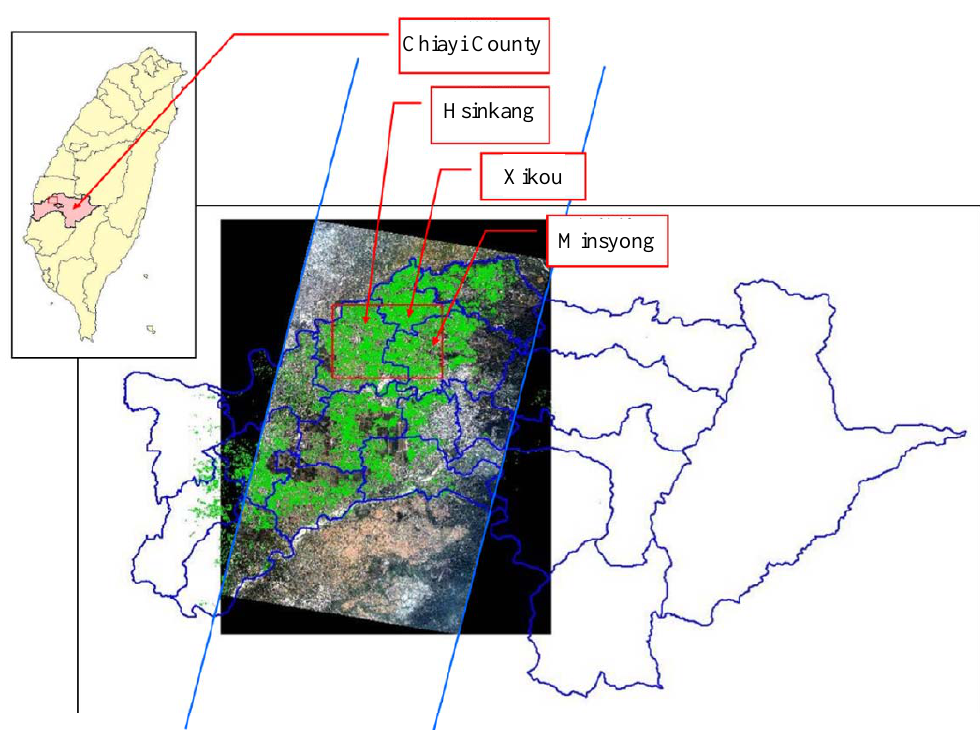
Fig. 1. Location of rice paddy areas in the Hsinkang, Xikou and Minsyong townships in Chiayi Fig. 1 Location of rice paddy areas in the Hsinkang, Xikou and Minsyong Townships in Chiayi County